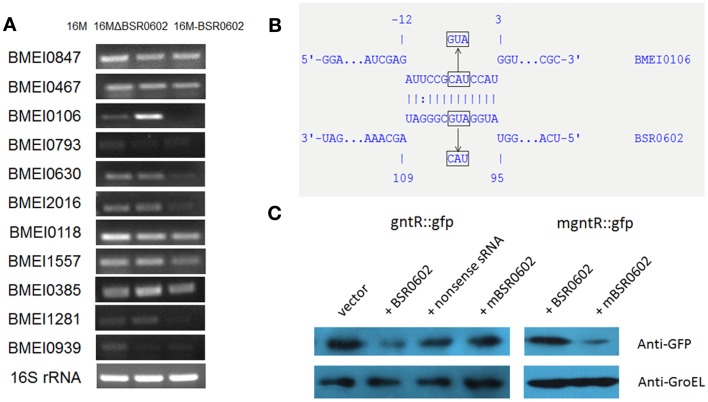
BSR0602 directly regulates gntR mRNA. (A) RT-PCR verification of predicted target mRNA of BSR0602. RNA was isolated from 16M, 16MΔBSR0602, and 16M-BSR0602 and relative transcription of predicted target mRNA genes was quantified and normalized with 16S rRNA. (B) Schematic representation of the proposed BSR0602–BMEI0106 interactions and of compensatory base-pair changes. Numbers indicate relative position to the translational start site of BMEI0106 or position downstream of the transcriptional start site of BSR0602. Arrows denote nucleotide substitutions (in box) introduced to BSR0602 and BMEI0106 mRNA. (C) Regulation of GntR-GFP reporter fusions by BSR0602. E. coli strains carrying only a gfp fusion plasmid, or with a combination of both the gfp fusion plasmid and sRNA-encoding plasmid, were grown in LB broth, and immunoblot analyses were carried out on total protein lysates to detect levels of GFP or GroEL. Compensatory base pair exchange used for confirming the BSR0602–gntR interaction was also tested by immunoblot analyses. mBSR0602 means mutant BSR0602; mgntR means mutant gntR.